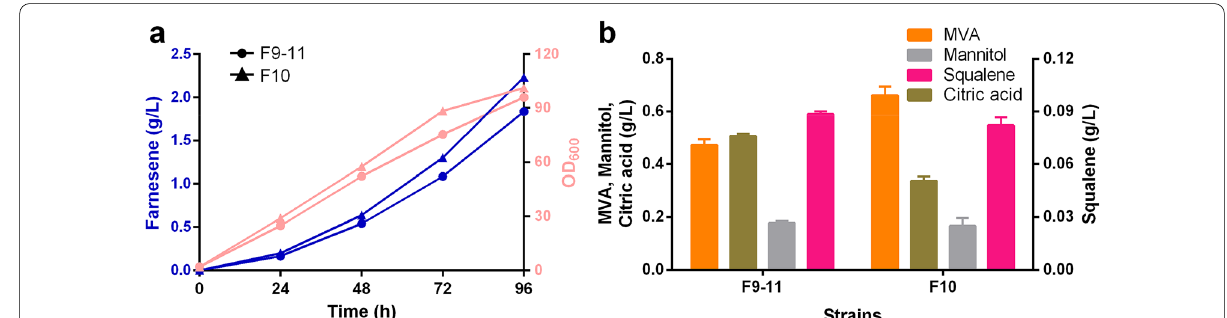
Fig. 4 α-Farnesene and other metabolites production in F9-11and F10 using oleic acid as substrate. a α-Farnesene accumulation curve of strains F9–11 and F10 during fermentation. b Citric acid, mannitol, squalene and mevalonate accumulation at 96 h. Data represent the mean biological